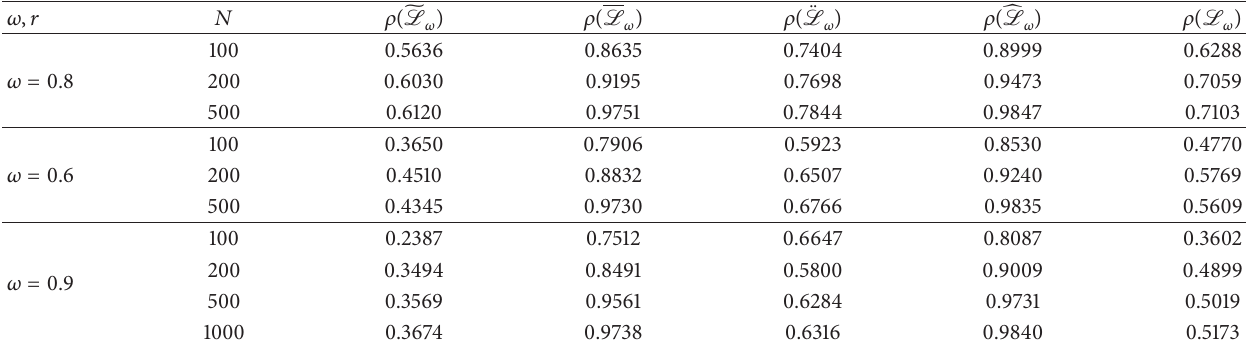
Table 1: Comparison of spectral radius with preconditioner 𝑃 1